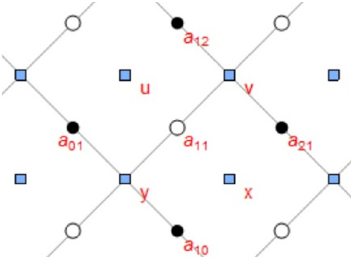
Figure 3 . Kink worldlines form a quad lattice on the string worldsheet (parametrized by τ and σ ). The field a ij lives on the edges (black or white dots depending on edge orientation).